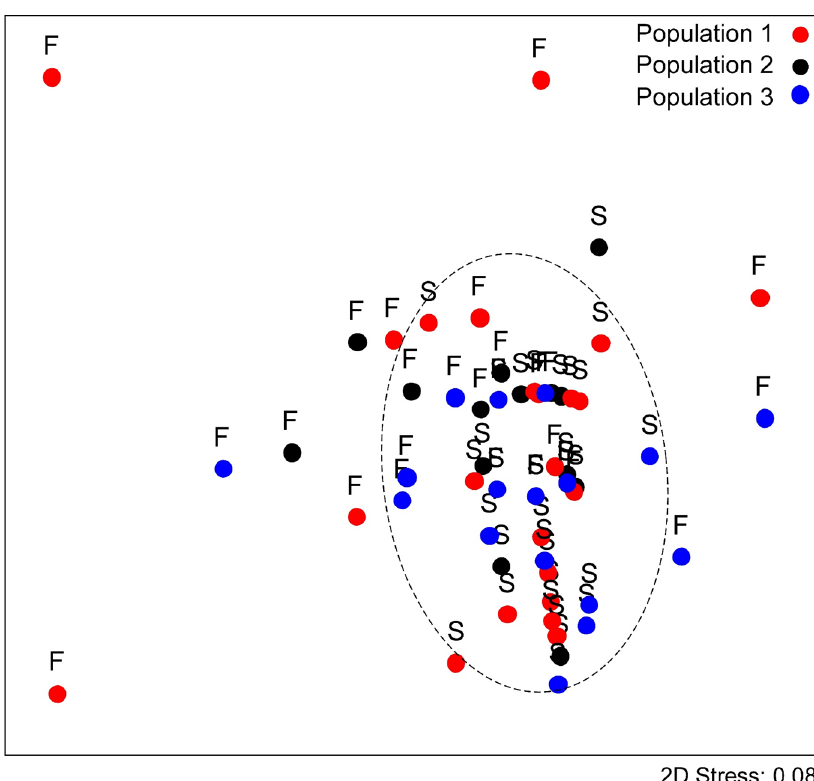
Figure 2. Non-metric multidimensional scaling plots (nMDS) of stomach content data of the three H. ambrosii populations. Letters indicate seasons (F = fall, S = spring). A 95% confidence ellipse is plotted around the spring data. Table 2. Seasonal, age/sex and body size-related effects on stomach content data values across the three analysed Hydromantes ambrosii populations: results of PERMANOVA run on Euclidean distances calculated on log-transformed data and performed under a reduced model using 9999 permutations. p (MC) = p -value obtained by the Monte Carlo permutation test. The table reports the significance of factors, also testing pairwise interactions. On the left side are shown results considering all salamanders, and on the right side, those considering adults only; factor three represents age for all salamanders and sex for adults only. nd = factor or interaction not tested due to unbalanced design; SVL = snout-vent length. All Salamanders Adult Factor